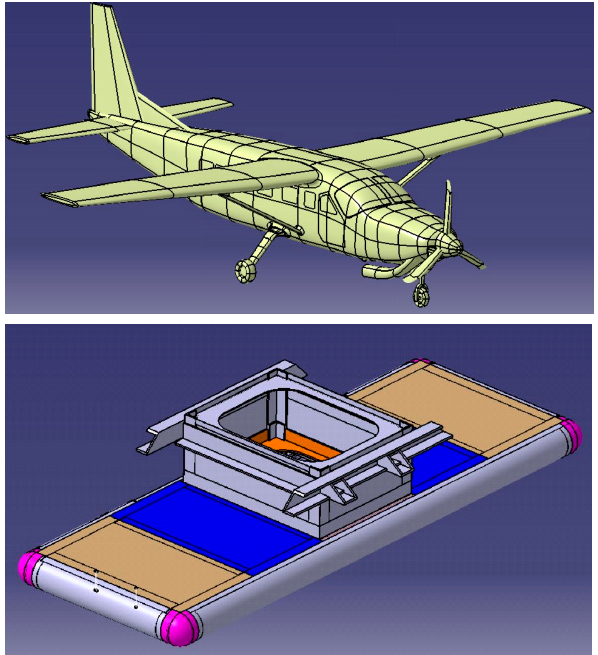
Figure 5. Y12 aircraft and experimental aircraft wing device.